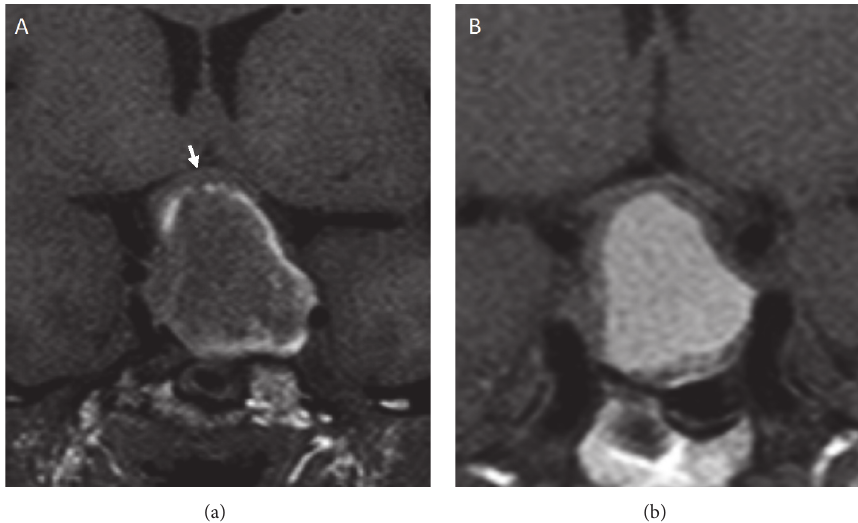
Figure 2: Coronal T1-weighted MRI images in two patients with pituitary apoplexy showing (a) intrasellar and suprasellar mass with a peripheral high signal intensity ring due to methemoglobin and slightly compressing the optic chiasm (white arrow) and (b) intrasellar and suprasellar mass with diffuse central high signal intensity.